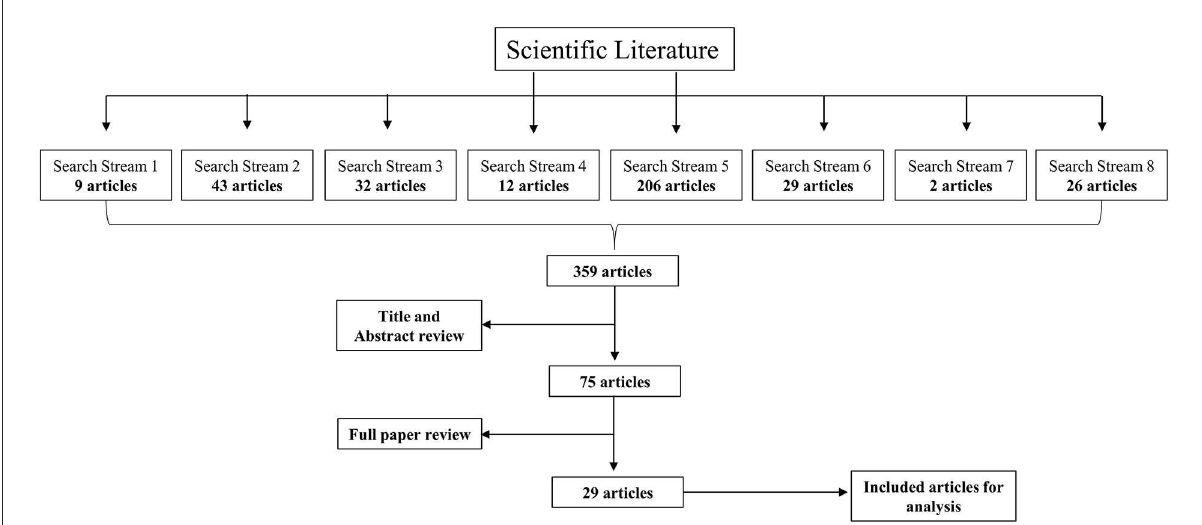
FIGURE1 Research procedure. Using the predefined search terms, the systematic literature review began with a total of 359 articles. The boxes in the first row indicate which search term produced how many results. Two screening rounds followed: First, titles and abstracts were screened, and articles that did not meet the inclusion criteria were excluded. Second, the full articles were screened. Finally, 29 articles met all search criteria (see Table